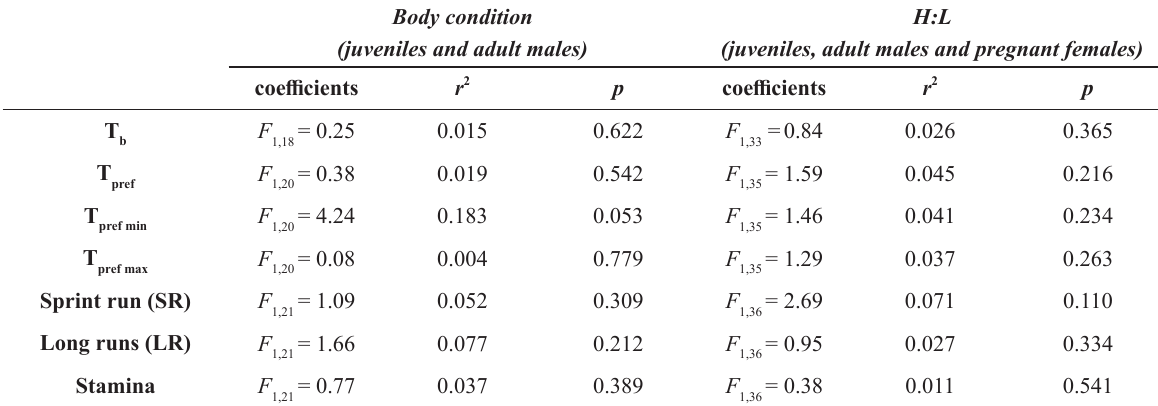
Linear Regression of body condition index (in pooled data of juveniles and adult males) and heterophil:lymphocyte ratio (H:L; in pooled data of juveniles, adult males, and pregnant females). Coefficients, correlation coefficient ( r 2 ), and p values are